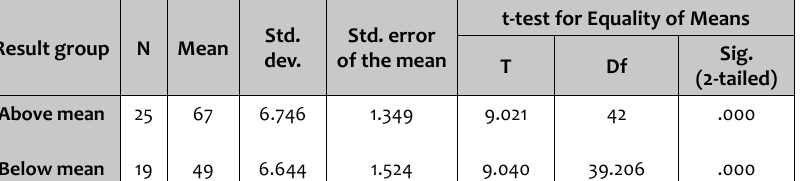
Table 3: Difference between high scoring and low scoring groups